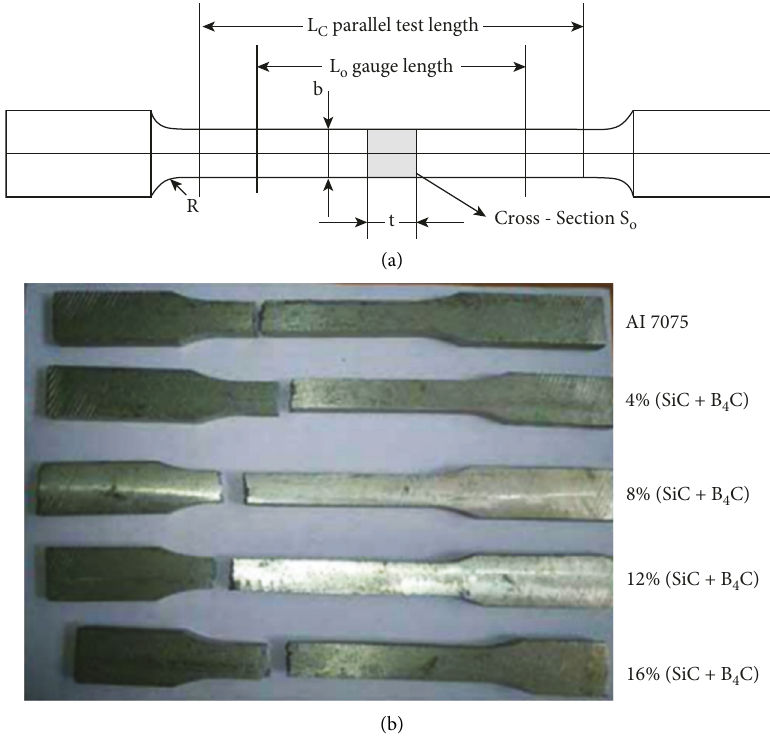
Figure 4: Tensile test. (a) Diagram and (b)